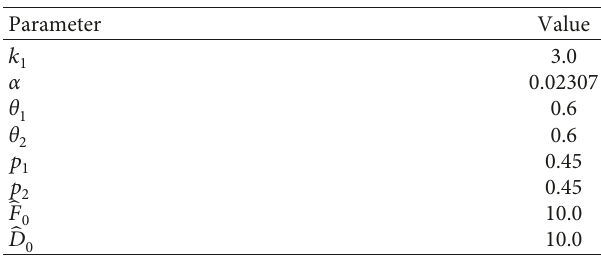
Table 3: M3 parameters.